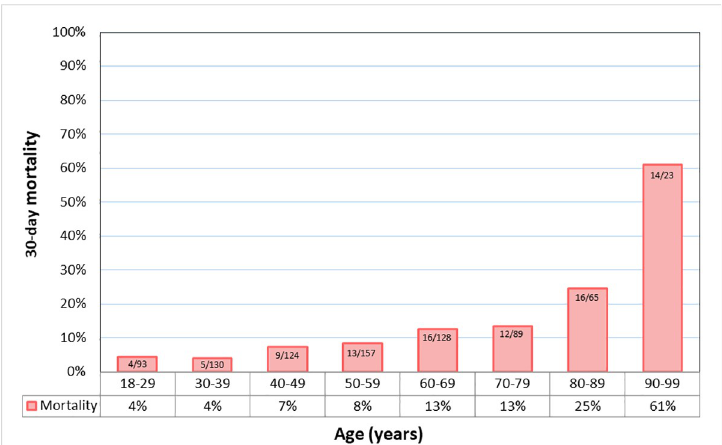
Fig 1. 30-day mortality by age group among 809 patients hospitalized with COVID-19 in